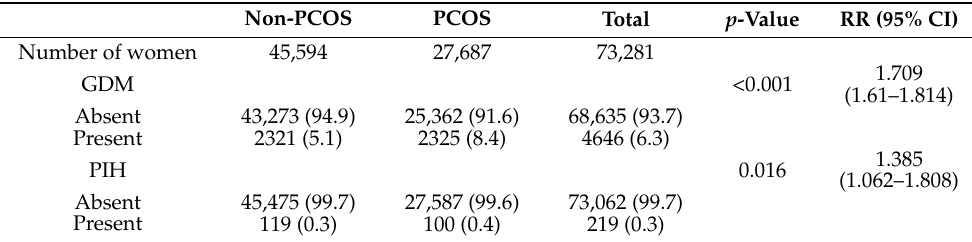
Figure 1. Flowchart of enrollment. DM—diabetes mellitus; GDM—gestational diabetes mellitus; HTN—hypertension; Í PCOS—polycystic ovary syndrome. Table 2. Incidence of GDM or PIH in women with and without PCOS, 2012–2020, from the National Health Insurance database.